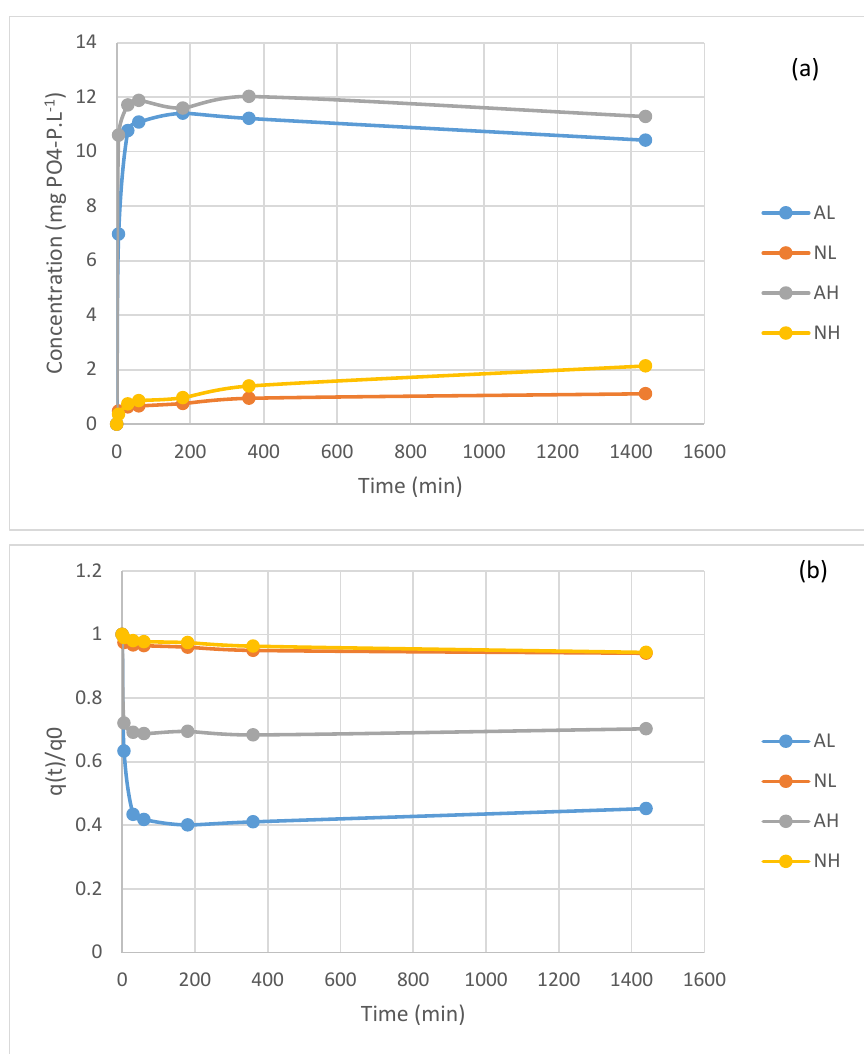
Figure 10. Phosphate release overtime (AL: pH = 4.6, initial loading = 1.904 mg · g − 1 ; AH: pH = 4.6, initial loading = 3.875 mg · g − 1 ; NL: pH = 7, initial loading = 1.904 mg · g − 1 and NH: pH = 7, initial Loading = 3.875 mg · g − 1 ): ( a ) Phosphate concentration in the solution; ( b ) Phosphate release from solid phase. Table 7. Desorption two term exponential model fitting